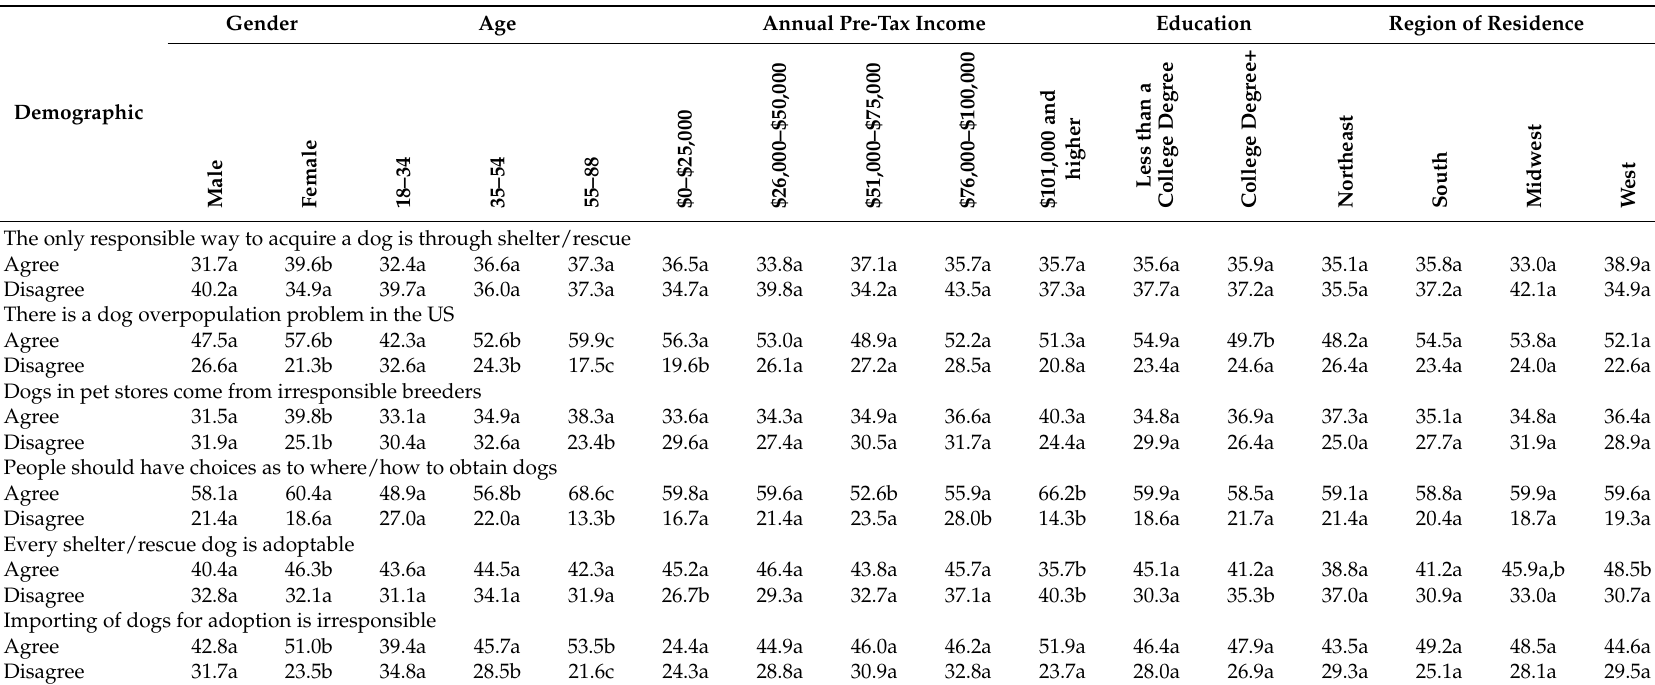
Table 3. Cross-tabulations of level of agreement regarding statements related to dog acquisition and potential welfare aspects (% of respondents; n = 507).